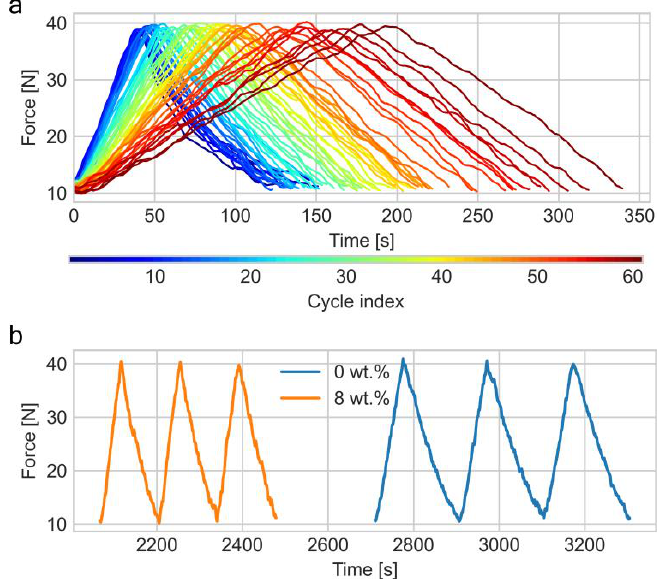
Figure 5. Results of multi-cyclic actuation experiments: ( a ) 61 actuation cycles of the 8 wt.% filler specimen, ( b ) comparison of cycles #15 to #18 for 0 wt.% filler and 8 wt.% filler specimens (real time scale).